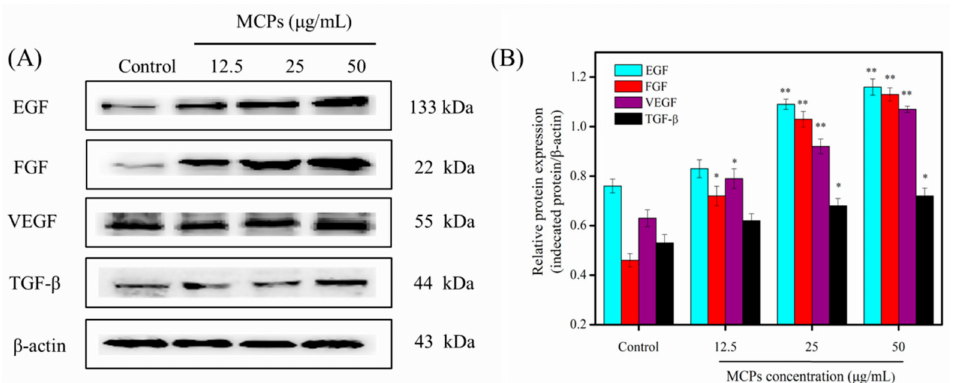
Figure 7. Effect of MCPs on the protein expression levels of epidermal growth factor (EGF), fibroblast growth factor (FGF), vascular endothelial growth factor (VEGF), and transforming growth factor (TGF- β ) in NIH-3T3 fibroblast cells. ( A ) Western blot analysis of the EGF, FGF, VEGF, and TGF in the NIH-3T3 cells treated with different concentrations MCPs overnight ( B ) Protein expression levels of EGF, FGF, VEGF, and TGF analyzed by western blotting. The data was obtained by using Image J 1.38 software and were expressed as the mean ± standard deviation ( x ± s , n = 6). * p < 0.05 and ** p < 0.001 vs.